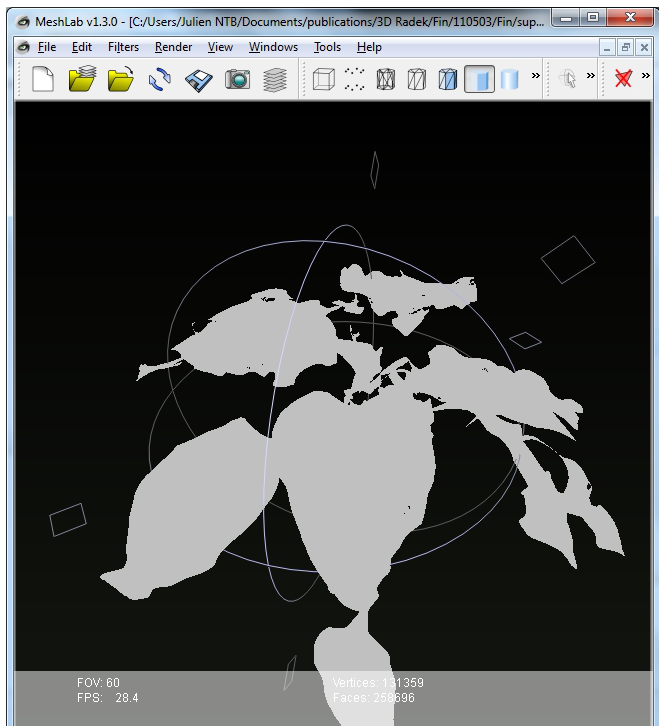
Figure 3. 3D point reconstruction of a pepper plant visualized by Meshlab open source software